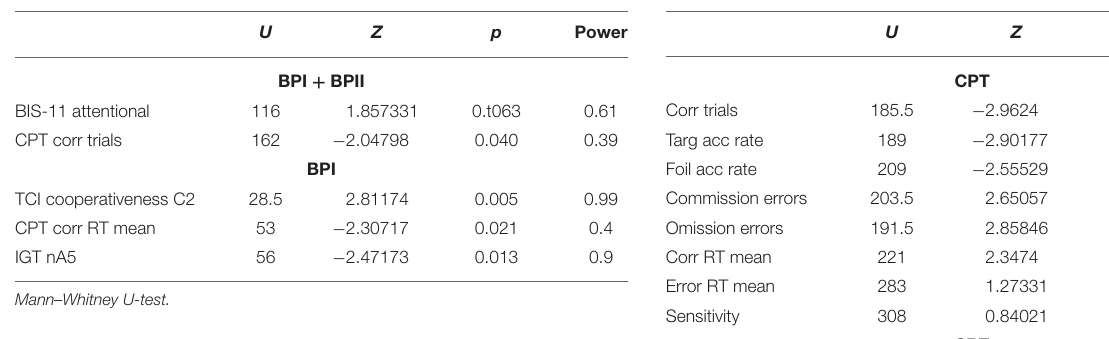
TABLE 3 | Comparison of CPT and SRT results between Bipolar I and Bipolar II patients.